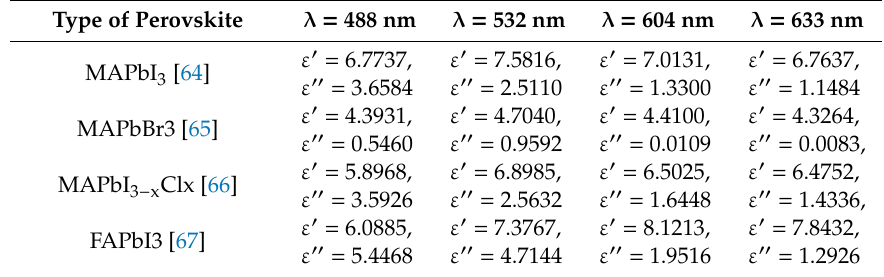
Table 1. The dielectric constants of MAPbI 3 , MAPbBr 3 , MAPbI 3 − x Cl x , and FAPbI 3 perovskites used for the modeling of GH-SPR sensitivity, which are obtained from experimental